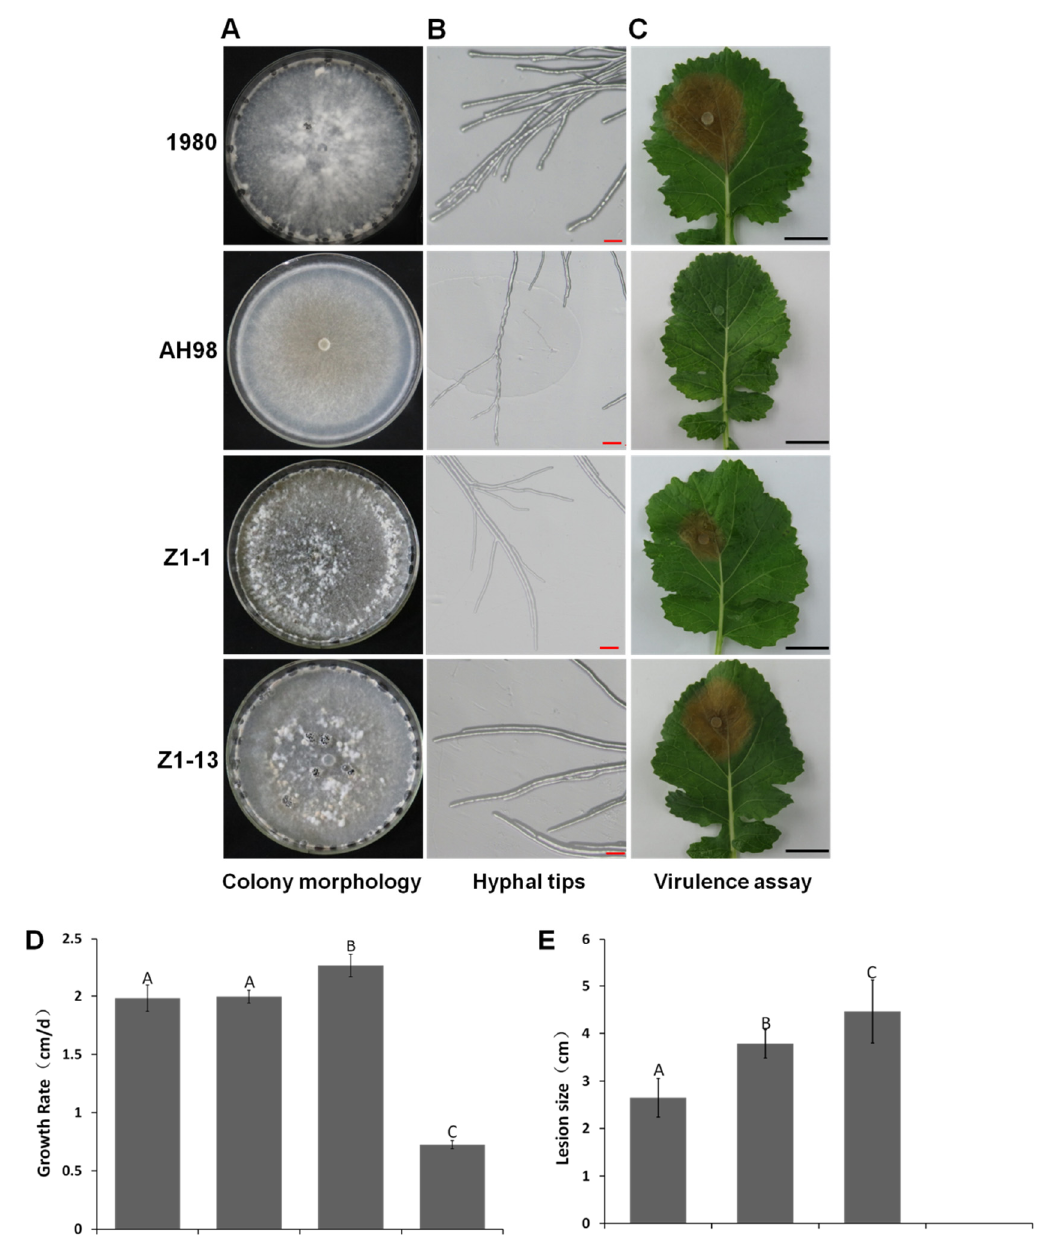
Figure 3. Biological characterization of Open Reading Frame I ( ORF I )-expressing strains Z1-1and Z1-13. ( A ) The colonial morphology of strains Z1-1, Z1-13, 1980 and AH98 after 10 days incubation on potato dextrose agar (PDA) at 20 ◦ C. ( B ) Hyphal tips of each strain after 48h incubation on PDA at 20 ◦ C. The hyphal tips of strains Z1-1, Z1-13 and AH98 were narrower than that of wild-type strain 1980. ( C ) The pathogenicity of each strain after 60h incubation on the detached leaves of canola plants at 20 ◦ C. ( D ) Growth rate of each strain on PDA at 20 ◦ C. ( E ) The diameter of lesions induced by each strain on detached leaves of canola plants. Error bars indicate the SD from five sample means. Means followed by the di ff erent letters on the top of each column are significantly di ff erent at the p < 0.05 level of confidence according to Duncan’s multiple range